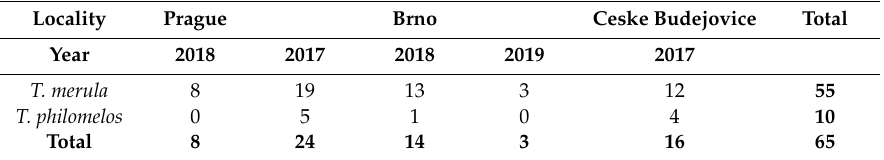
Figure 1. Localization of the cadavers of blackbirds ( Turdus merula ) and song thrushes ( T. philomelos ) collected in 2017–2019 in the three geographical locations in the Czech Republic (indicated in black in the overview map of Europe) and used for detection of Usutu virus (USUV). ( a ) Localization of the three main sampling sites (cities of Prague, Brno and Ceske Budejovice) and localization of the three additional USUV positive samples collected outside the area of the three cities are depicted in the map of the Czech Republic. The region of South Moravia is labeled by a blue background and the region of South Bohemia by green. Bird pictogram indicates an USUV positive blackbird, collected in the town of Breclav-South Moravia); mosquito pictograms indicate USUV positive mosquito pools (pool of Cx. modestus collected near Hlohovec-South Moravia in yellow, Culex pipiens collected near Lomnice nad Luznici-South Bohemia in red). Position of cadavers of blackbirds and song thrushes collected in the three cities are presented in the remaining maps: Prague ( b ), Ceske Budejovice ( c ), Brno ( d ). Blackbirds negative for USUV genomic RNA are indicated in black, USUV positive blackbirds in red, and song thrushes (all USUV negative) in violet. Table 1. Numbers of cadavers of blackbirds ( Turdus merula ) and song thrushes ( T. philomelos ) collected in the three geographical locations in the Czech Republic,